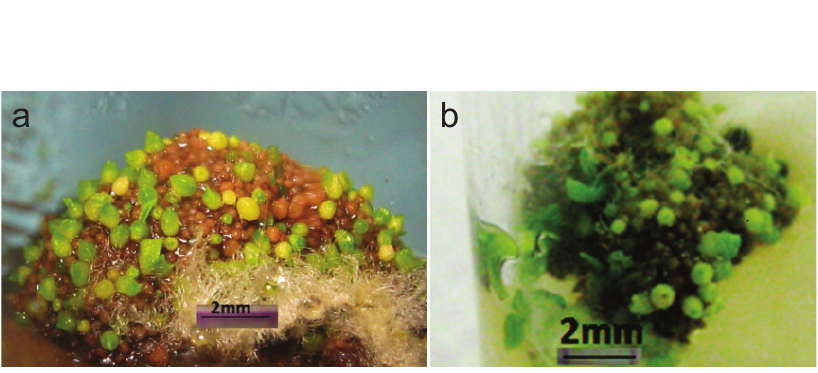
Figure 4. (a) PLB formation in Beclardia macrostachya on media with BAP (1.0mg/L) and (b) subsequent plantlet development.